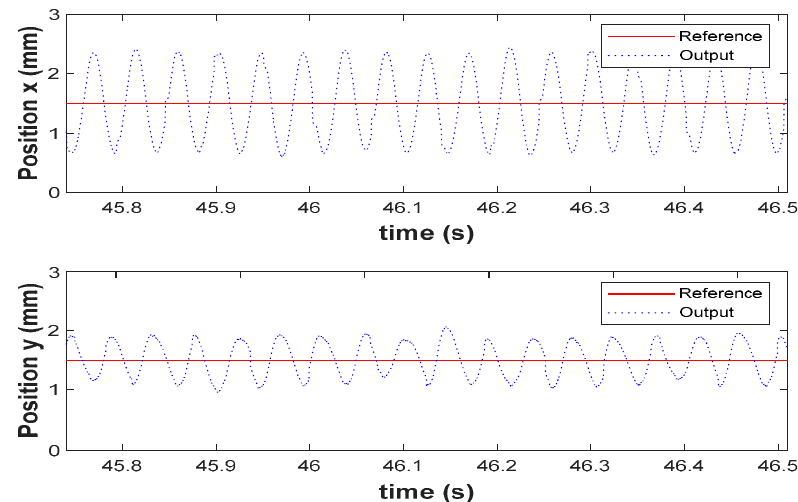
Figure 16. The response of AMB at 500 rpm in both x and y planes.